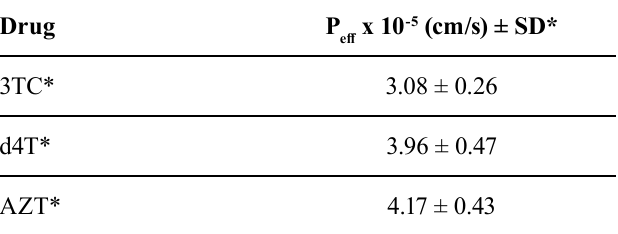
TABLE III – P results of 3TC, d4T, and AZT obtained from eff the SPIP experiments (Dezani et al.,